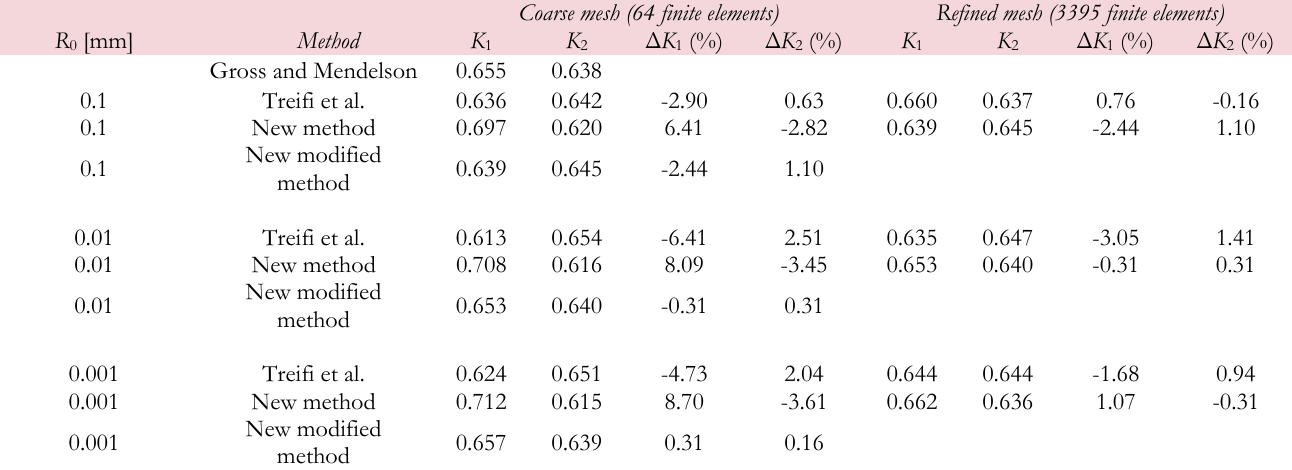
Table 4: Comparison between approximate methods for NSIFs evaluation of central tilted crack (2 α = 0°) in a plate of finite